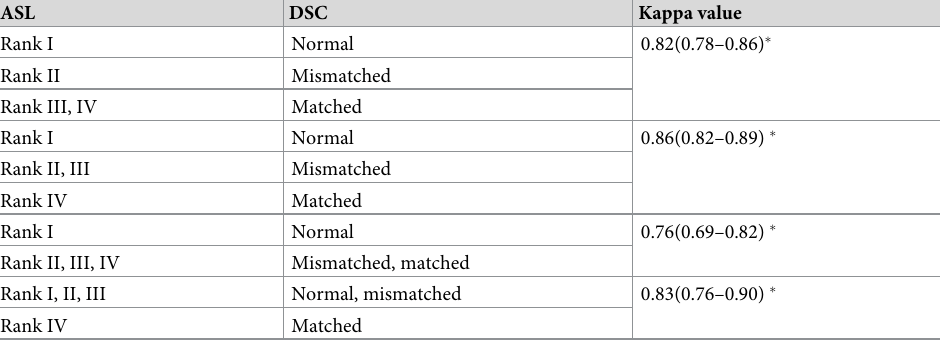
Rank IV Matched ASL, arterial spin labeling; DSC, dynamic susceptibility contrast � Numbers within brackets are 95% confidence interval of the Kappa